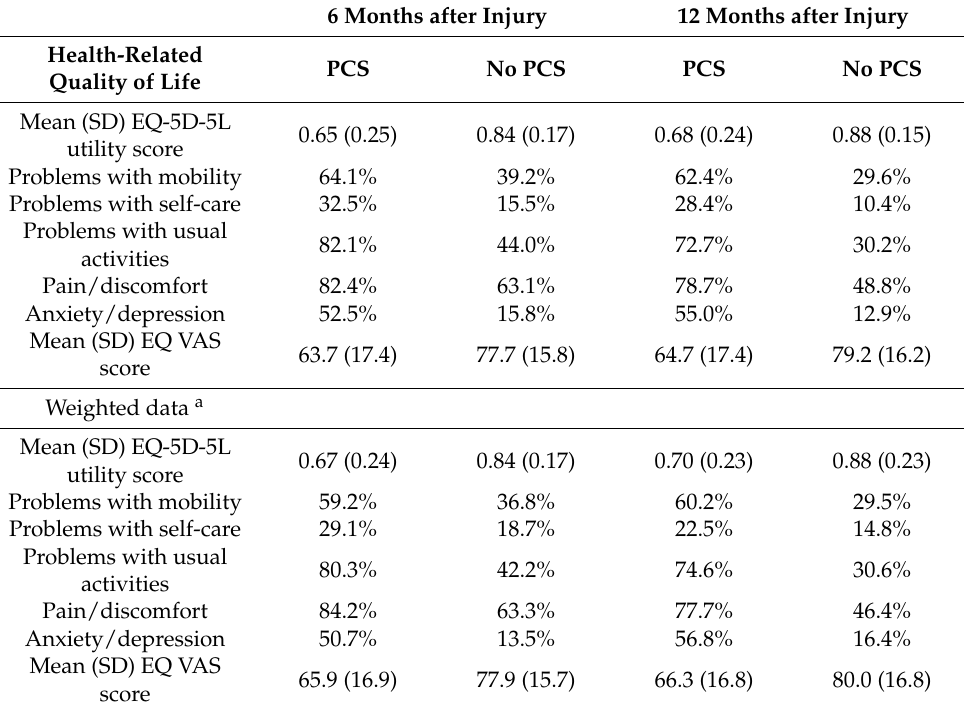
Table 3. Mean T1 (6 months) and T2 (12 months) five-level, five-dimensional descriptive system (EQ-5D-5L) utility and visual analogue scale (EQ VAS) scores and percentage of patients reporting problems on EQ-5D-5L dimensions, for patients with and without post-concussion syndrome ( ≥ 3 of the core post-concussion symptoms).